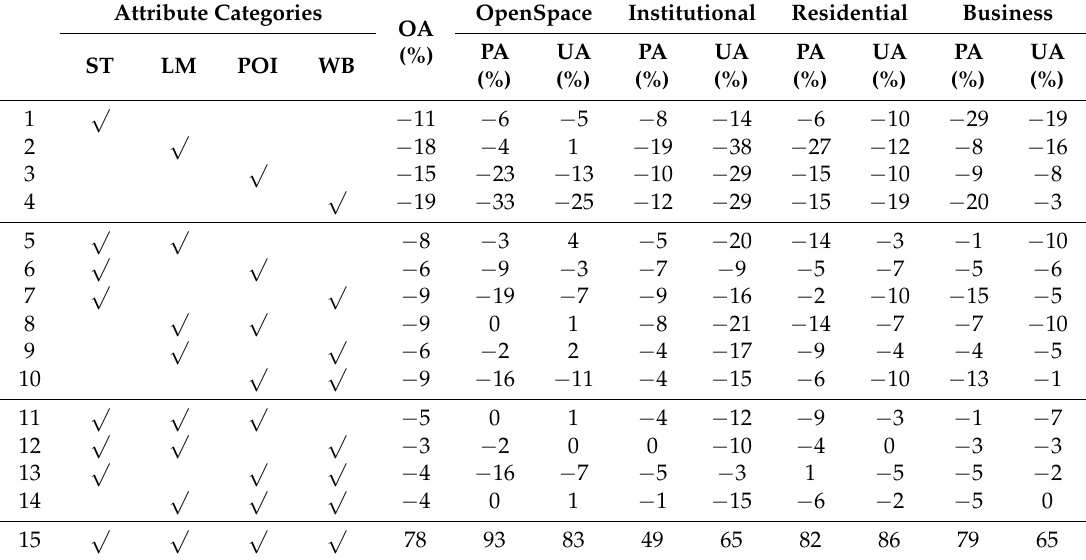
Table 4. Overall producer’s and user’s accuracies of urban land use classification using